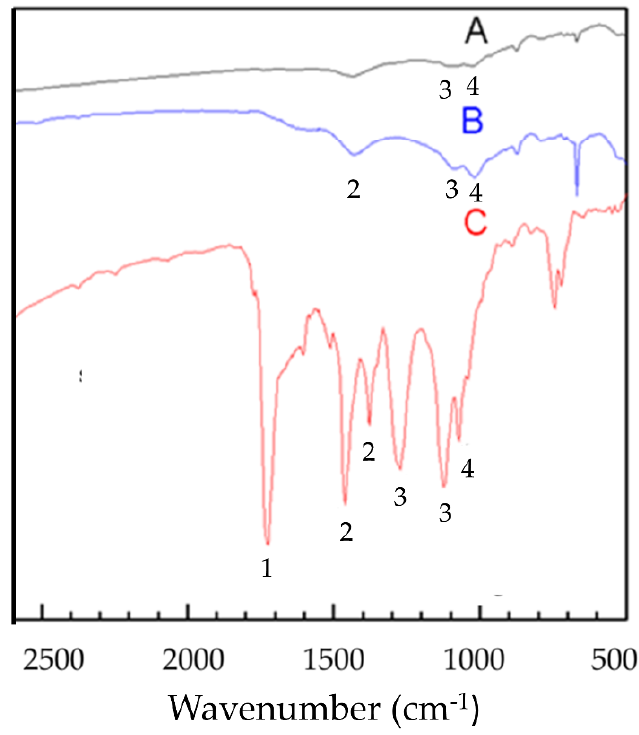
Figure 4. The FT-IR spectra of two kinds of crumb rubber and cracking oil. A : The as-received crumb rubber; B : the partially oxidized crumb rubber; C : cracking oil. (1: CO stretching, 2: CH bending, 3: SO 2 stretching, 4: SO stretching).